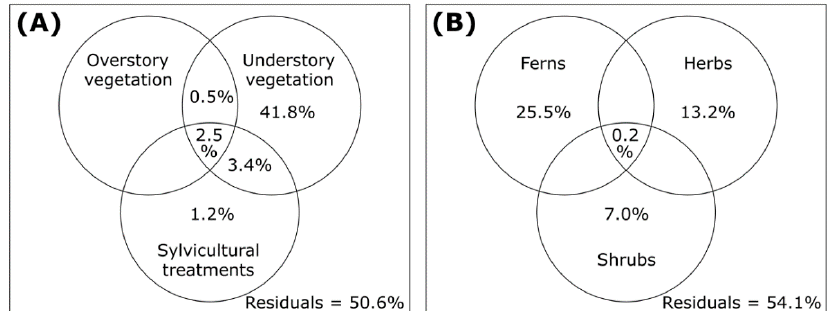
Figure 1. Canonical correspondence analysis of overstory vegetation composition using silvicultural treatments 27 years after establishment of a white pine plantation. Silvicultural treatments significantly explained overstory vegetation composition variation at p < 0.001 (R 2 adj = 0.49).